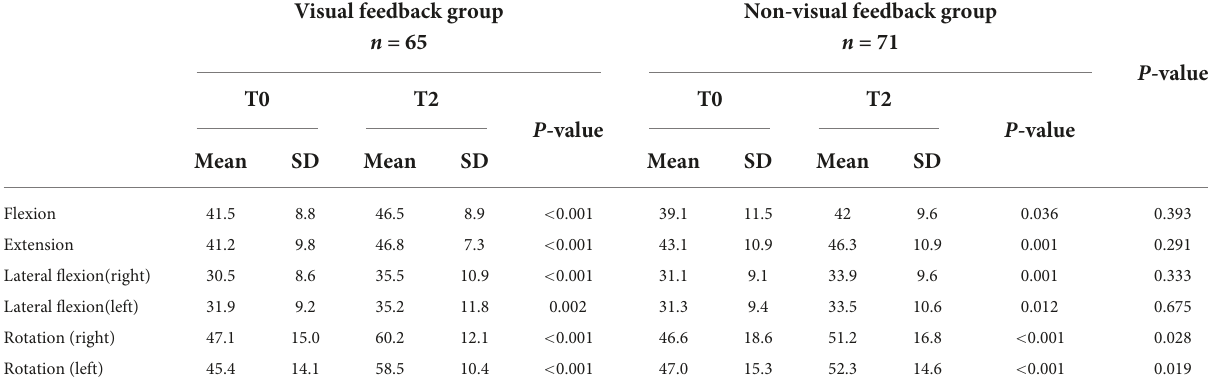
TABLE 2 Cervical range of motion scores in the visual feedback and non-visual feedback groups and the comparison of differences within and between group. Visual feedback group Non-visual feedback group